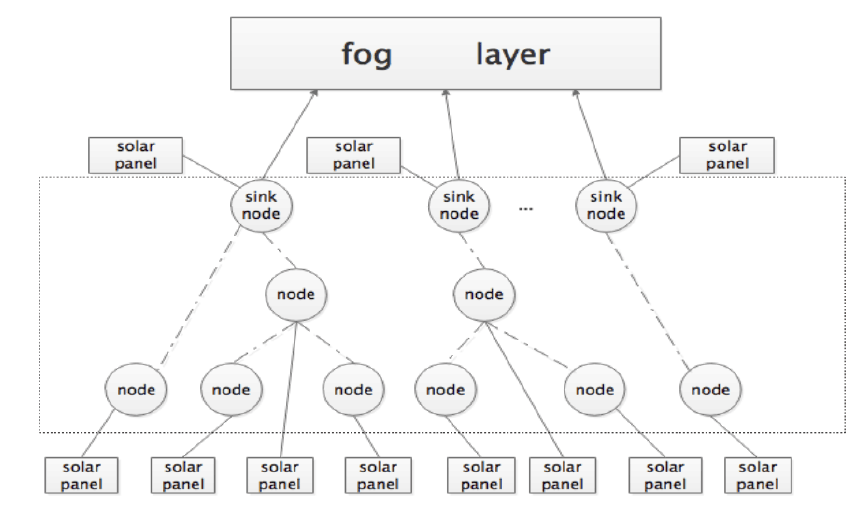
Figure 7. Proposed terminal layer model.